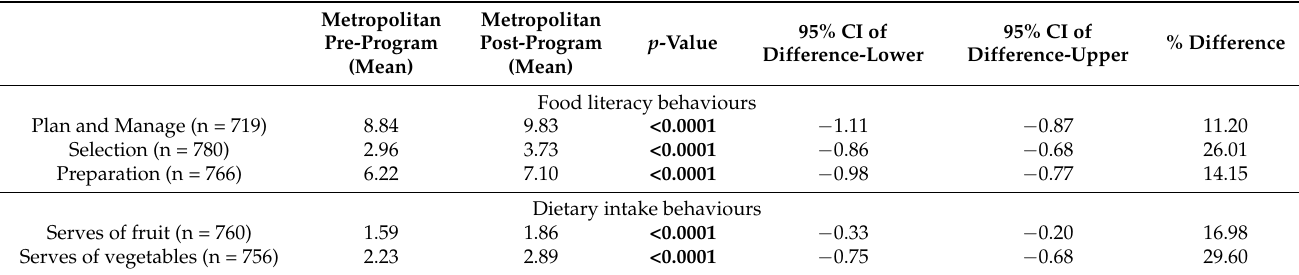
Table 5. Paired t-tests comparing metropolitan pre- and post-program scores for the three food literacy behaviour domains and change in self-reported dietary intake of fruits and vegetables.